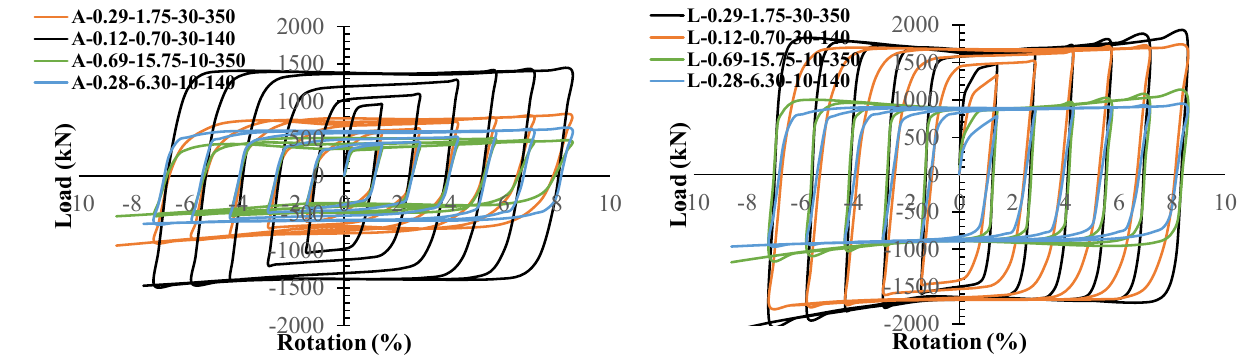
Figure 5. Comparing the hysteresis curve of the dampers.